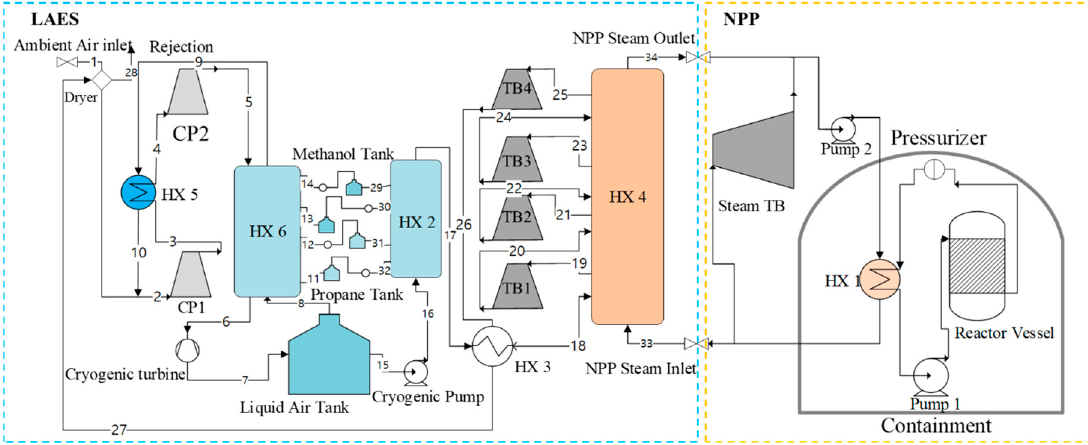
Figure 1. LAES system with a reference nuclear power plant (NPP) system with design limitations adapted from [15].